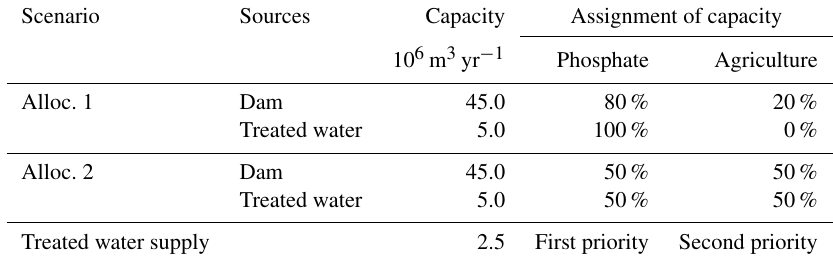
Table 8. Water allocation and treated water use